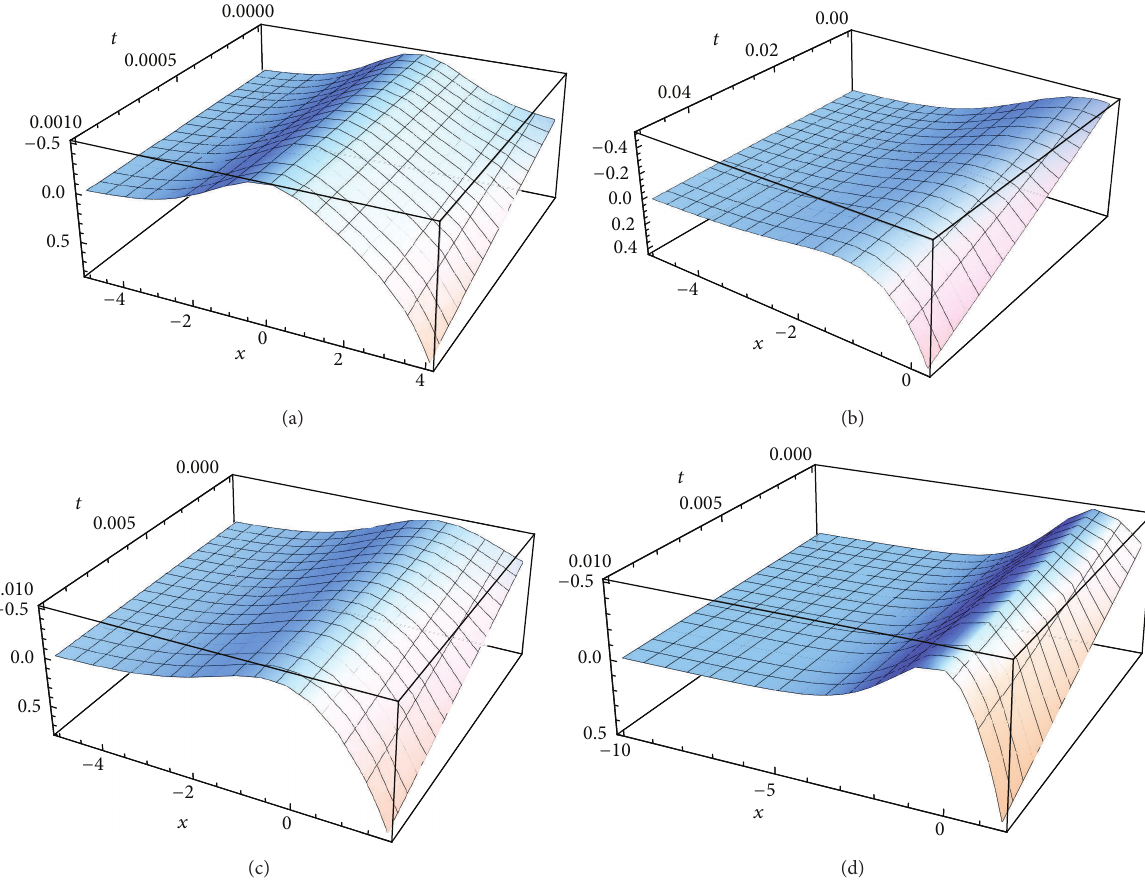
Figure 7: The HAM solution at 17th-order approximation with different convergence values of ℎ . (a and b) for ℎ = −0.5 , (c) for ℎ = −1.0 , and (d) for ℎ = −1.7